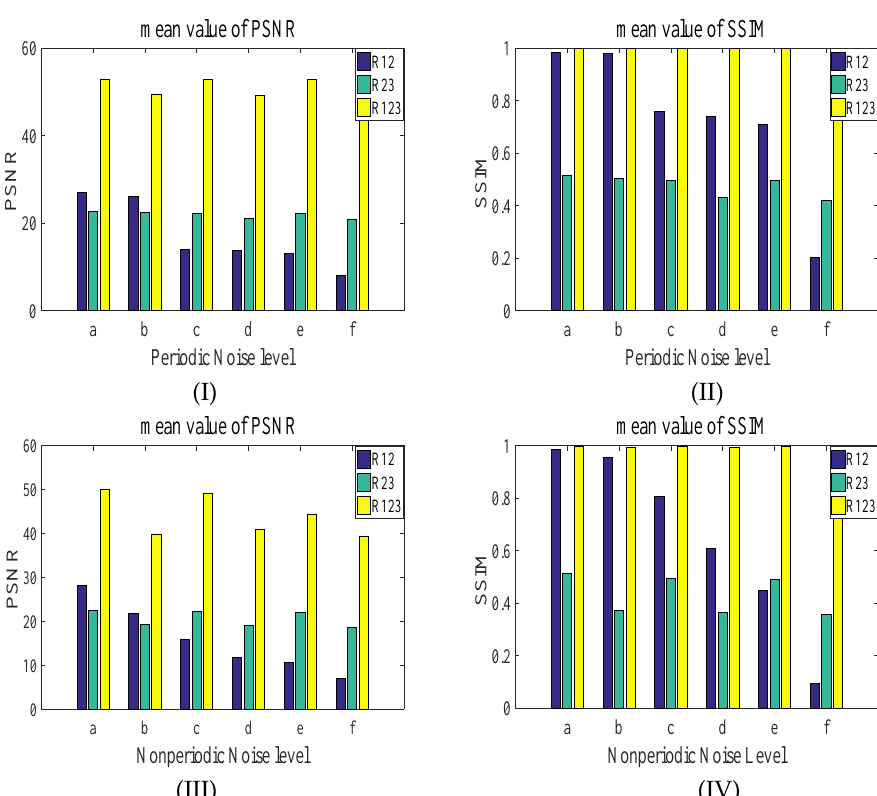
Figure 13. The influence of different terms in the proposed model. R 12 represents R 1 + R 2 , R 23 stands for R 2 + R 3 and R 123 represents R 1 + R 2 + R 3 (i.e., the proposed model). (I) The mean PSNR performance on 32 images for periodic stripes with different stripe levels; (II) The mean SSIM performance on 32 images for periodic stripes with different stripe levels; The stripe levels (a–f) stand for (Per, 10, 0.2), (Per, 10, 0.6), (Per, 50, 0.2), (Per, 50, 0.6), (Per, 100, 0.2) and (Per, 100, 0.6), respectively. (III) The mean PSNR performance on 32 images for nonperiodic stripes with different stripe levels; (IV) The mean SSIM performance on 32 images for nonperiodic stripes with different stripe levels. The stripe levels (a–f) stand for (NonPer, 10, 0.2), (NonPer, 10, 0.6), (NonPer, 50, 0.2), (NonPer, 50, 0.6), (NonPer, 100, 0.2) and (NonPer, 100, 0.6),